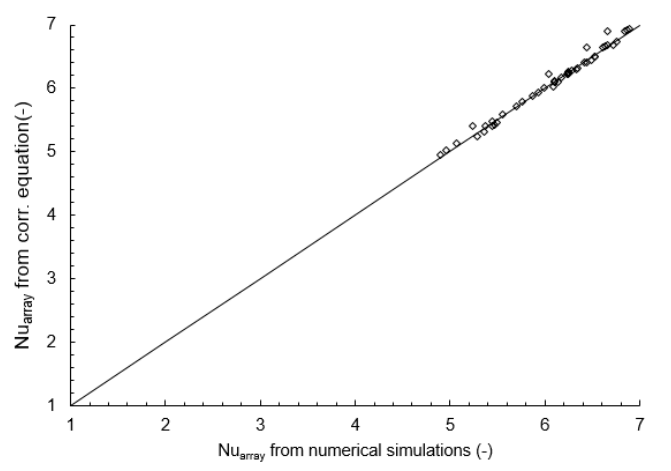
Figure 17. Comparison between presented correlating equations and numerical results.